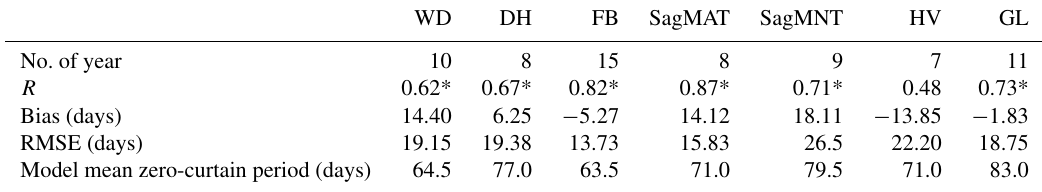
Table 4. Comparisons of model-simulated and in situ observed zero-curtain period at 0.35m soil depth for sites along the DHN transect. The model-simulated mean zero-curtain period was calculated from 2001 to 2016. The zero-curtain period calculated using in situ soil temperatures at closely adjacent sites (e.g., the three Franklin Bluff sites, Table S1) were combined for a longer observational record.